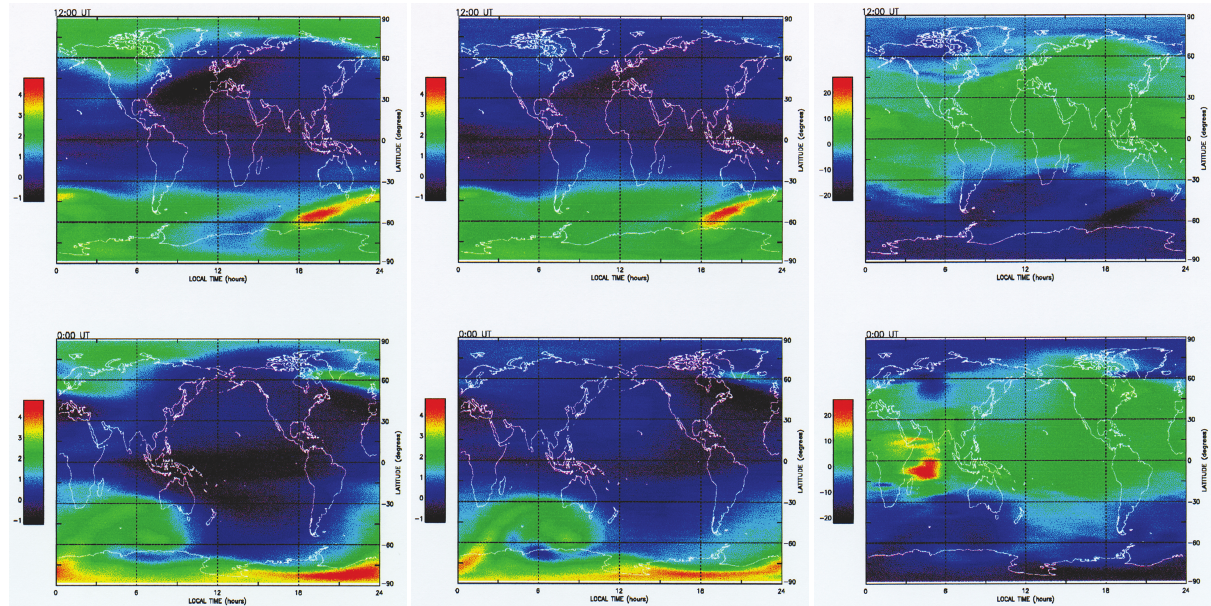
Fig. 8. The percentage change in the neutral temperature on pressure level 13 (approximately at the F-region peak) for (cid:15) 6 = 1 . 4 at December solstice for (top left) 1200 UT and (bottom left) 2400 UT. The corresponding plots for mean molecular mass ( MMM ) (middle), and the peak concentration at F-region altitudes (NmF2)